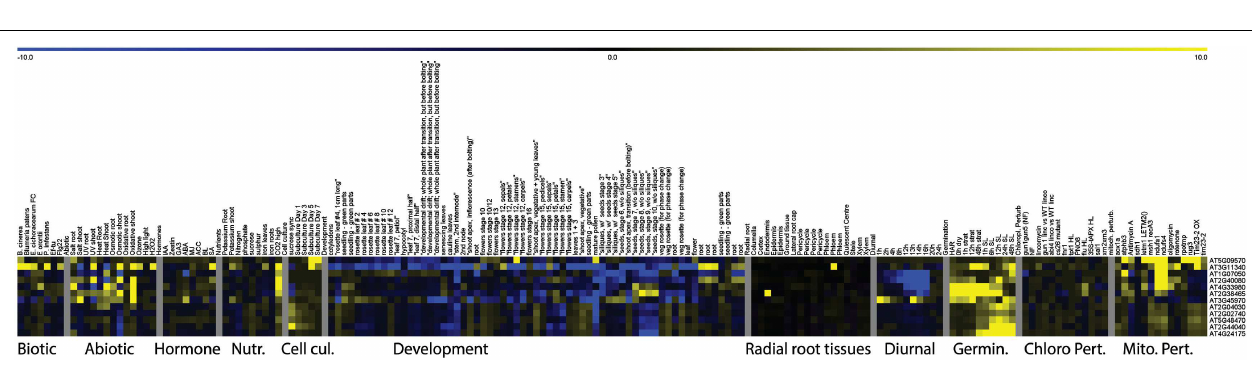
experiments relating to mitochondrial perturbations and 0 or 1 chloroplast perturbations in a variety of stress and development related microarray